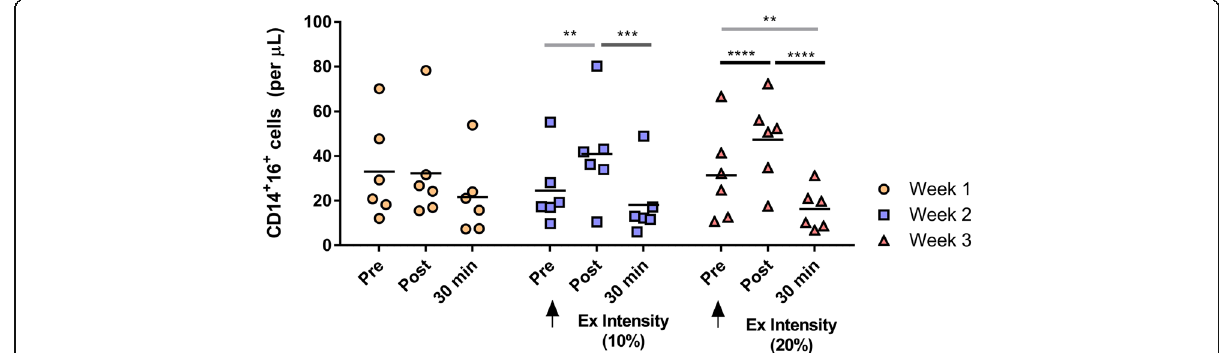
Fig. 12 Circulating numbers of CD14 + CD16 + monocytes during 3 weeks of exercise training ( N = 6). Significant effect of time ( P < 0.0001) and interaction (time x intensity; P = 0.02) were detected. Post hoc significance using Tukey ’ s multiple test: ** P < 0.01, *** P < 0.001, **** P < 0.0001. No significant main effect of intensity was observed ( P > 0.05)